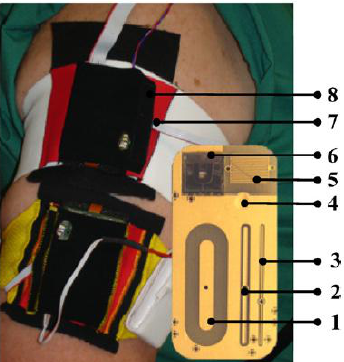
Figure 2. Arm module proposed in [23] (1) deep, (2) mid and (3) shallow electrodes. (4) Temperature sensor. (5) Sweat sensor. (6) Siliconwafer based optical reflection sensor. (7) Humidity sensor. (8) 3-axes acceleration